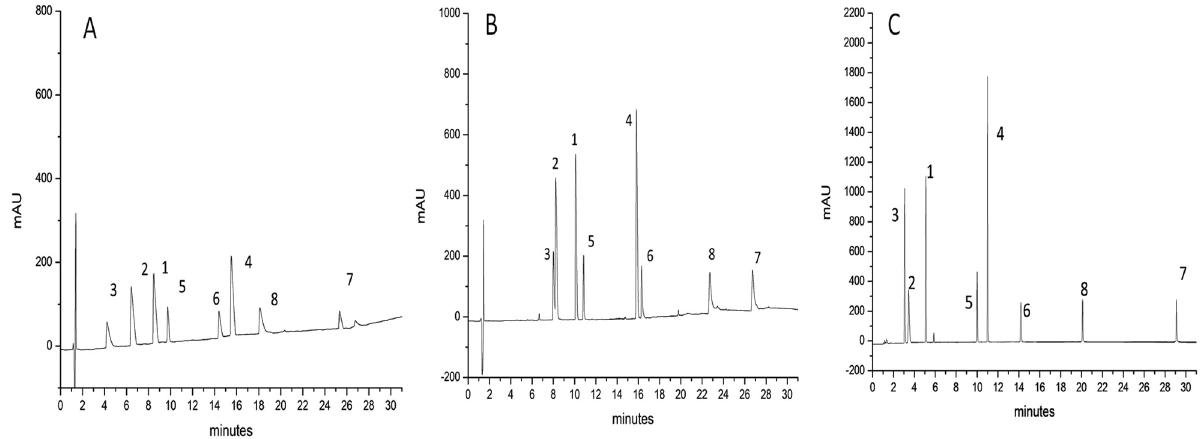
Figure 3. Chromatograms refer to the separation of eight peptides (see Table 1). Column used: Halo peptide ES-C18 (150 × 3.0 mm L × I.D.) 2.0 μ m 160 Å SPP. ( A ) MP with 0.1% v/v FA; ( B ) MP with 0.1% v/v TFA; ( C ) MP with 10 mM TBAHSO 4 .